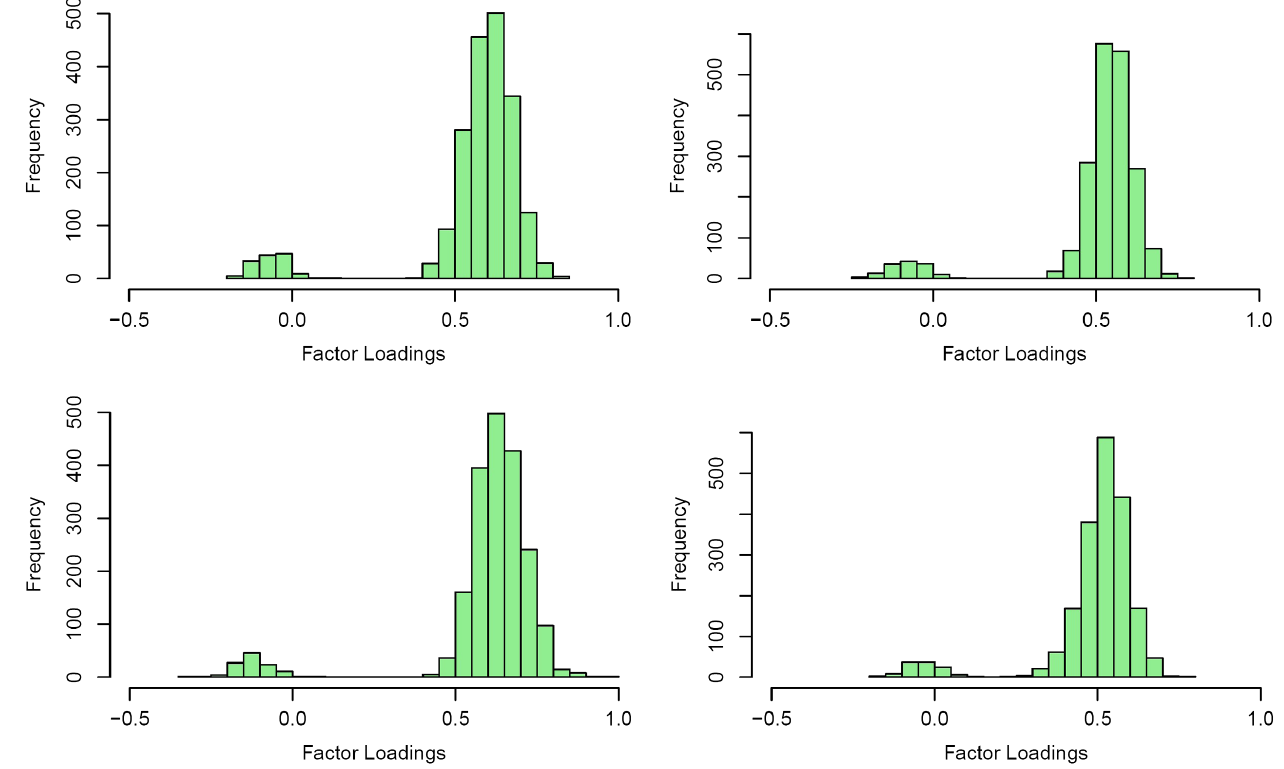
FIG. 3. Example distributions of factor loadings from replication analysis. Top row shows CLASS items 14 (left) and 37 (right) from factor 1 (personal), bottom row shows CLASS items 5 (left) and 29 (right) from factor 2